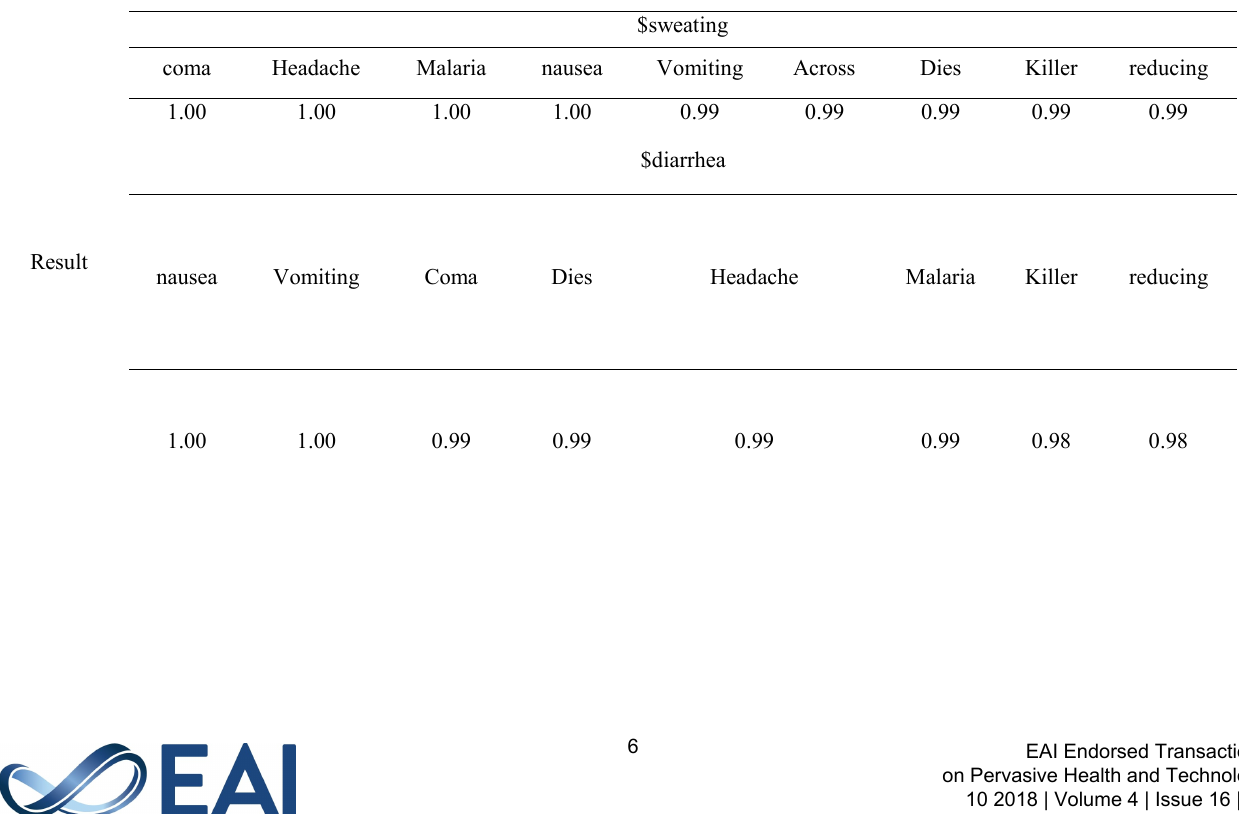
Table 6. Association between the ailments with 98% correlation